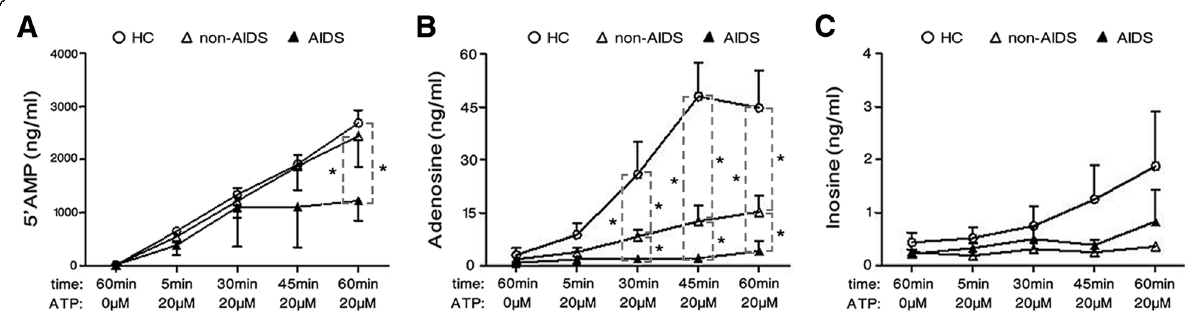
Fig. 3 Decreased production of ADO by B cells in patients with HIV-1 infection. Purified B cells were incubated in the presence of 20 μ M ATP for 5, 30, 45, and 60 min and the concentration of 5 ′ AMP ( a ), ADO ( b ), and inosine ( c ) in collected supernatants were detected using mass spectrometry. * p <